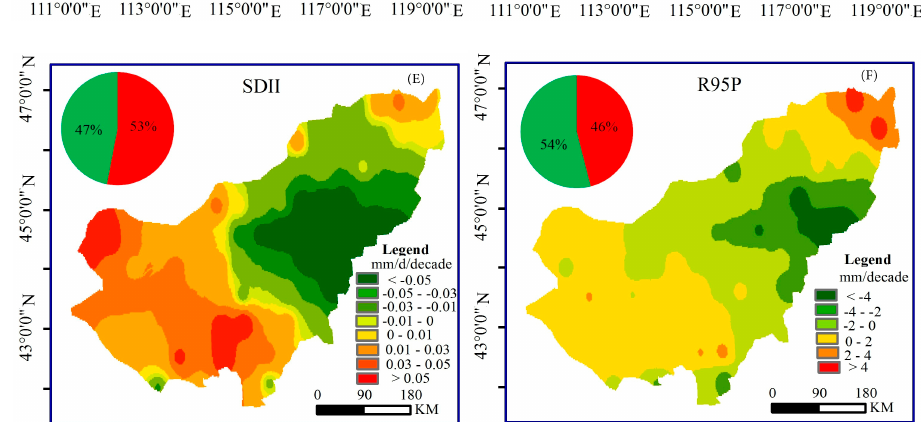
Table 4. Factor analysis of extreme precipitation indices.